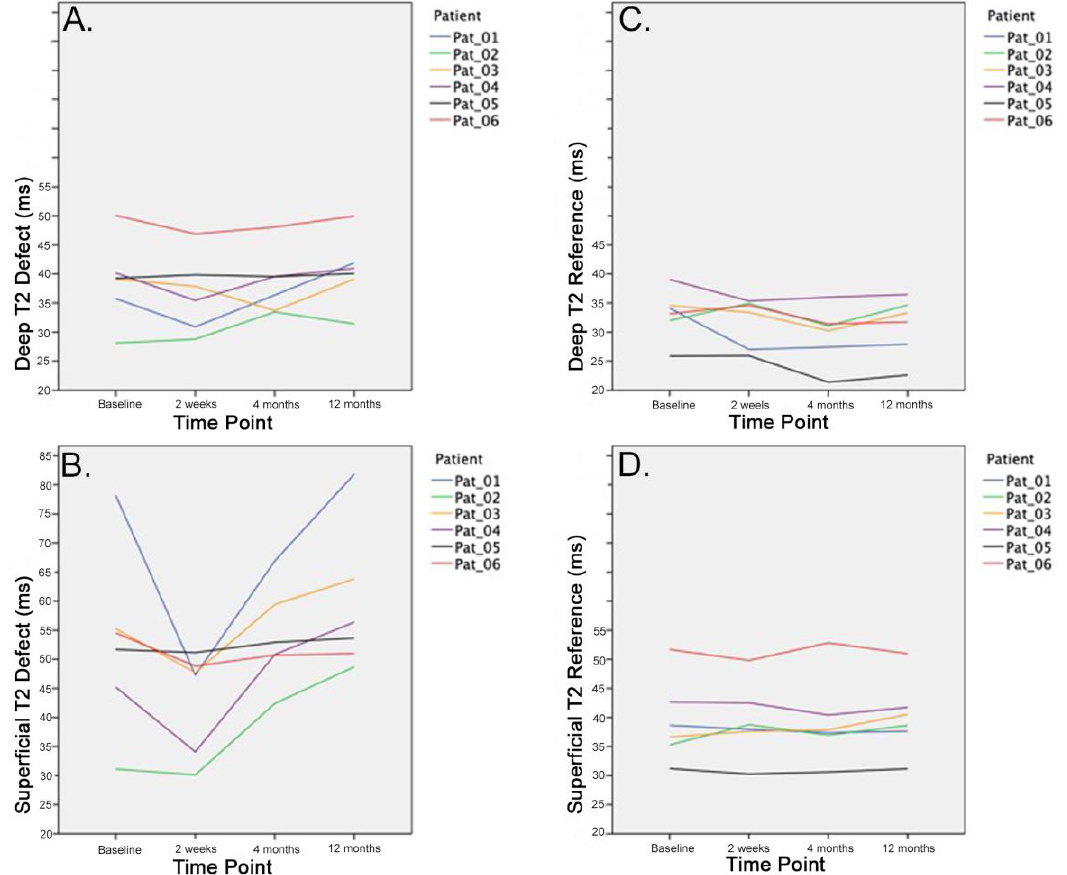
changes were observed at the reference site over the time course of 12 months ( B ).